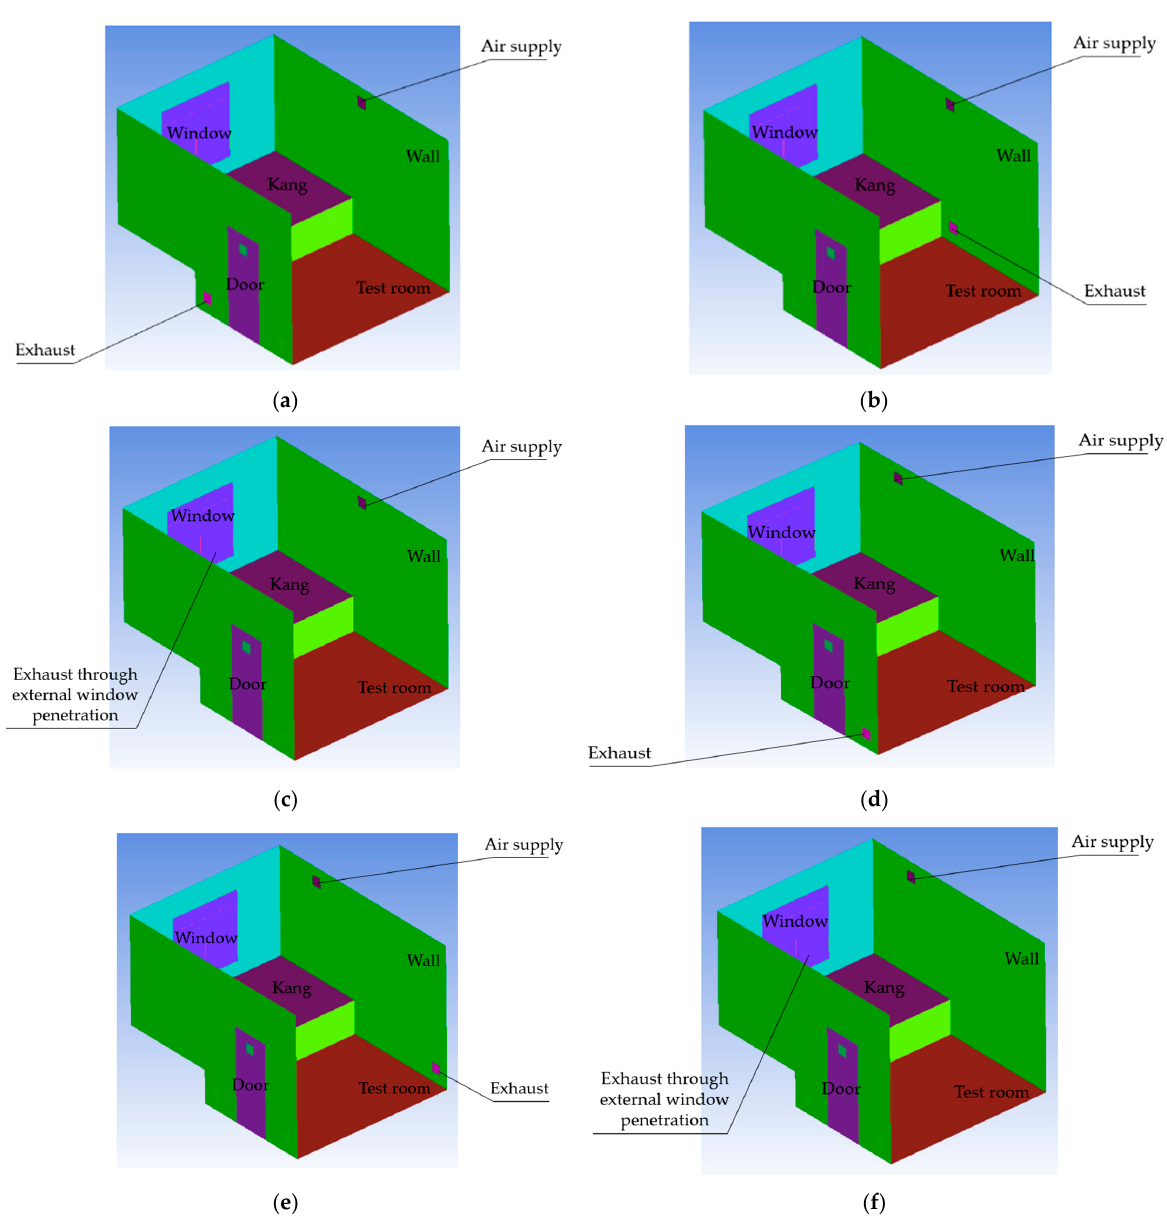
Figure 11. Six layout schemes of air supply and exhaust vents: ( a ) MOUSLE, ( b ) MSUSLE, ( c ) MUSEWP, ( d ) DOUSLE, ( e ) DSUSLE, ( f ) DUSEWP.